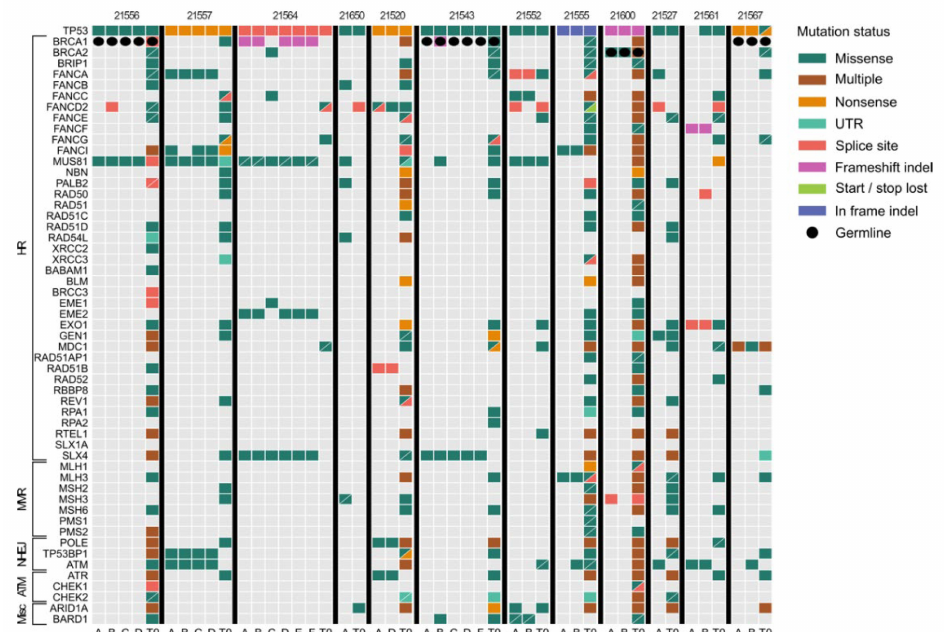
Figure 2. The different genomic profiles of liquid and solid biopsies at the time of diagnosis. For cases enrolled within cohort A (columns), oncoprint depicts all non-synonymous variants called in the coding sequence of the selected 65 genes (horizontal lines). For each patient, A, B, C, D identify each single tumor biopsy (see Supplementary Table S1), while T0 refers to the ctDNA analysis. The details of the different variants are reported in the legend on the right side. Gray block means wild